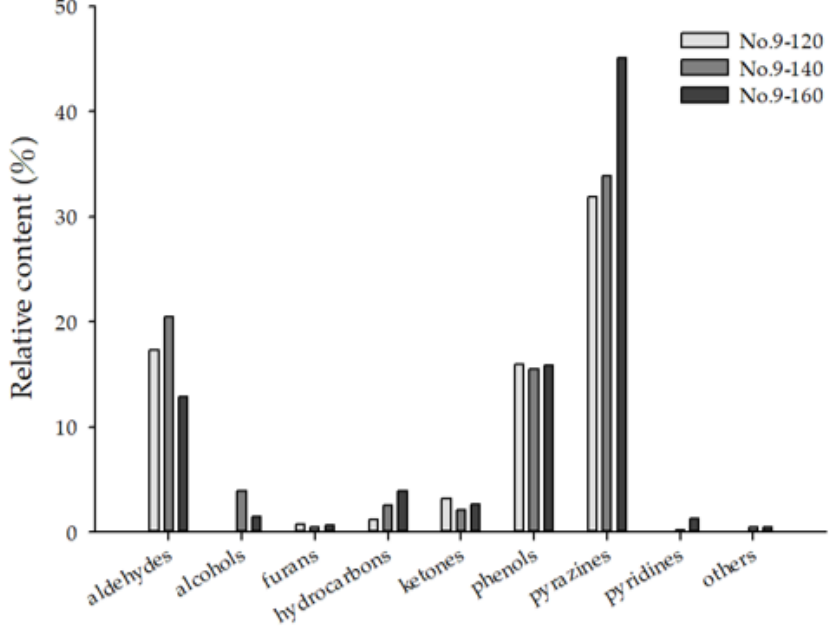
Figure 4. Classification of volatile compounds in Tainan S. No. 9 peanut oils using HS-SPME.